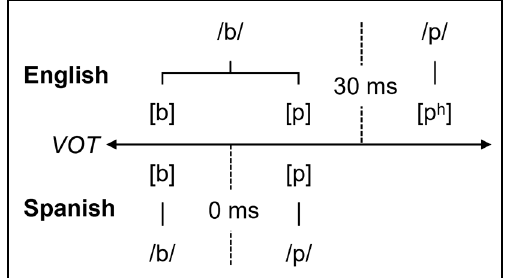
Figure 1. Comparison of the phonetics and phonology of English and Spanish stop consonants. The vertical dashed lines represent the approximate crossover points from voiced to voiceless stops.